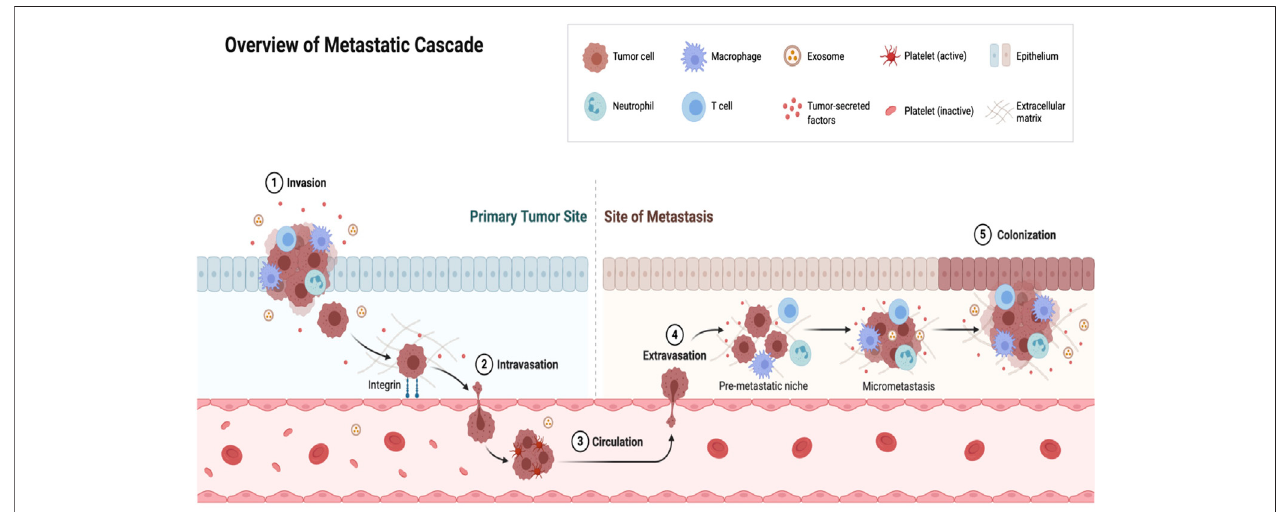
FIGURE1| Eventsoflungmetastasis.Theprimarytumorregulatesthedevelopmentofmetastasisinadistalorgansuchasthelungbysecretingfactorssuchas(cytokines and exosomes) that primes pre-metastatic niche formation. Following local invasion by primary tumor cells, the broken away tumor cells intravasateinto circulation as circulating tumorcells(CTCs).Uponsurvivingshearstressasaresultofbloodandimmunesurveillance,CTCsthatreachadistalorganwithapremetastaticnicheextravasateintotheorgan with the help of the pre metastatic niche where they exist as disseminated tumor cells (DTCs). The pre-metastatic niche promotes the survival of DTCs and remodel the microenvironment by inducing immunosuppression and other events to drive micro-metastasis and eventual colonization of the distal organ by the primary tumor